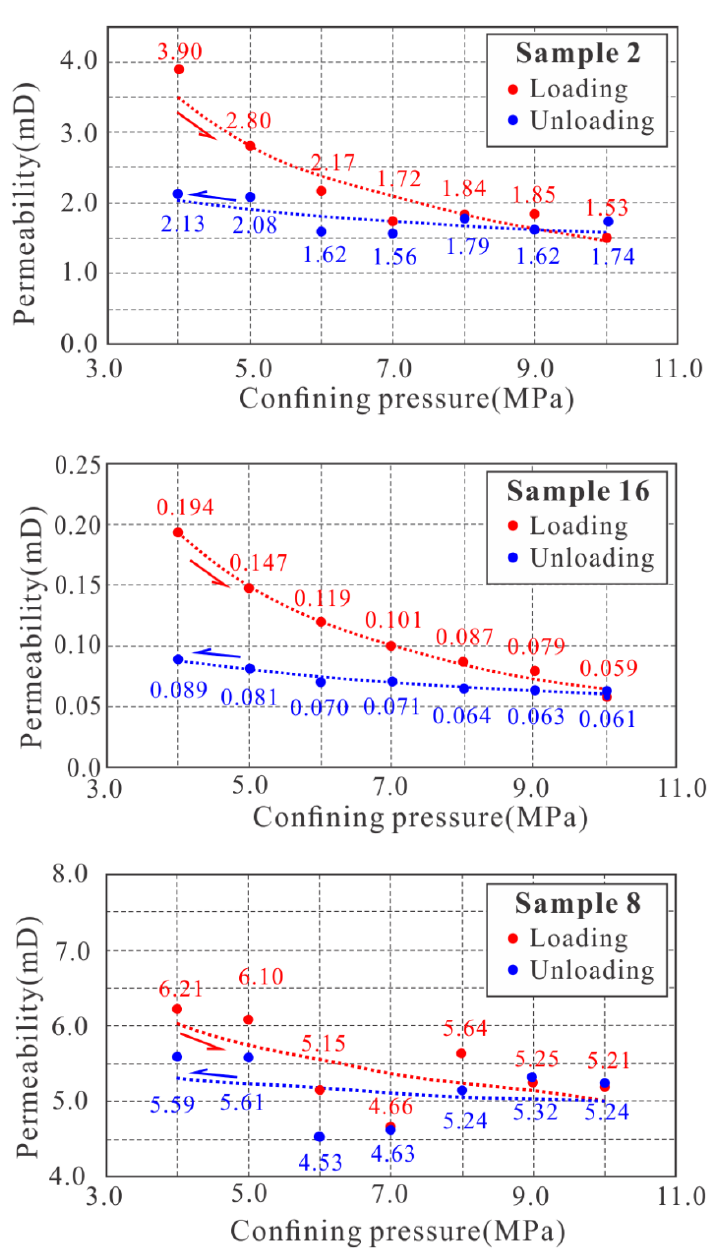
Figure 7. Klinkenberg permeability as a function of confining pressure during loading–unloading sequences for Samples 2, 16, and 8. Overall, the permeability shows hysteretic behavior and different degrees of permeability recovery depending on whether (Samples 2 and 16) or not (Sample 8) micro-fractures are present in the rock.